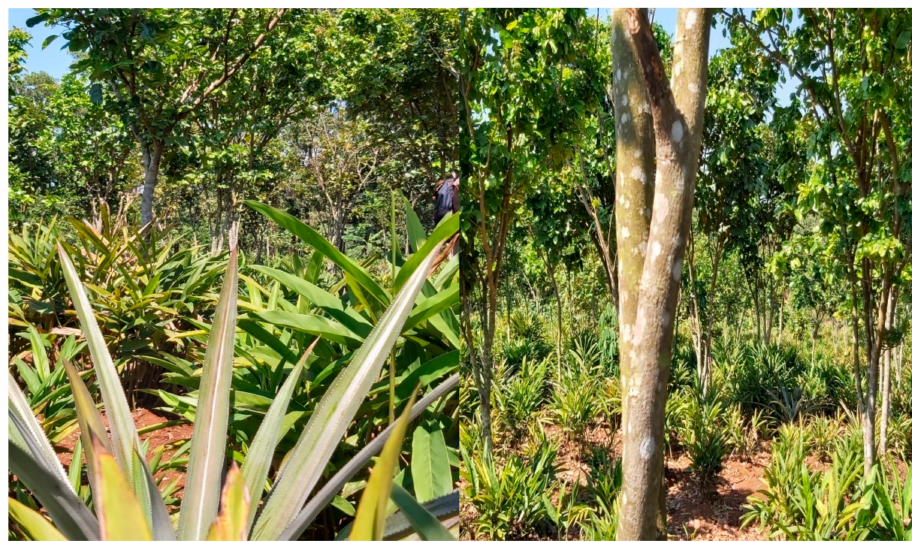
Figure 4. A pongamia-based agroforestry system in Parung Panjang, West Java,